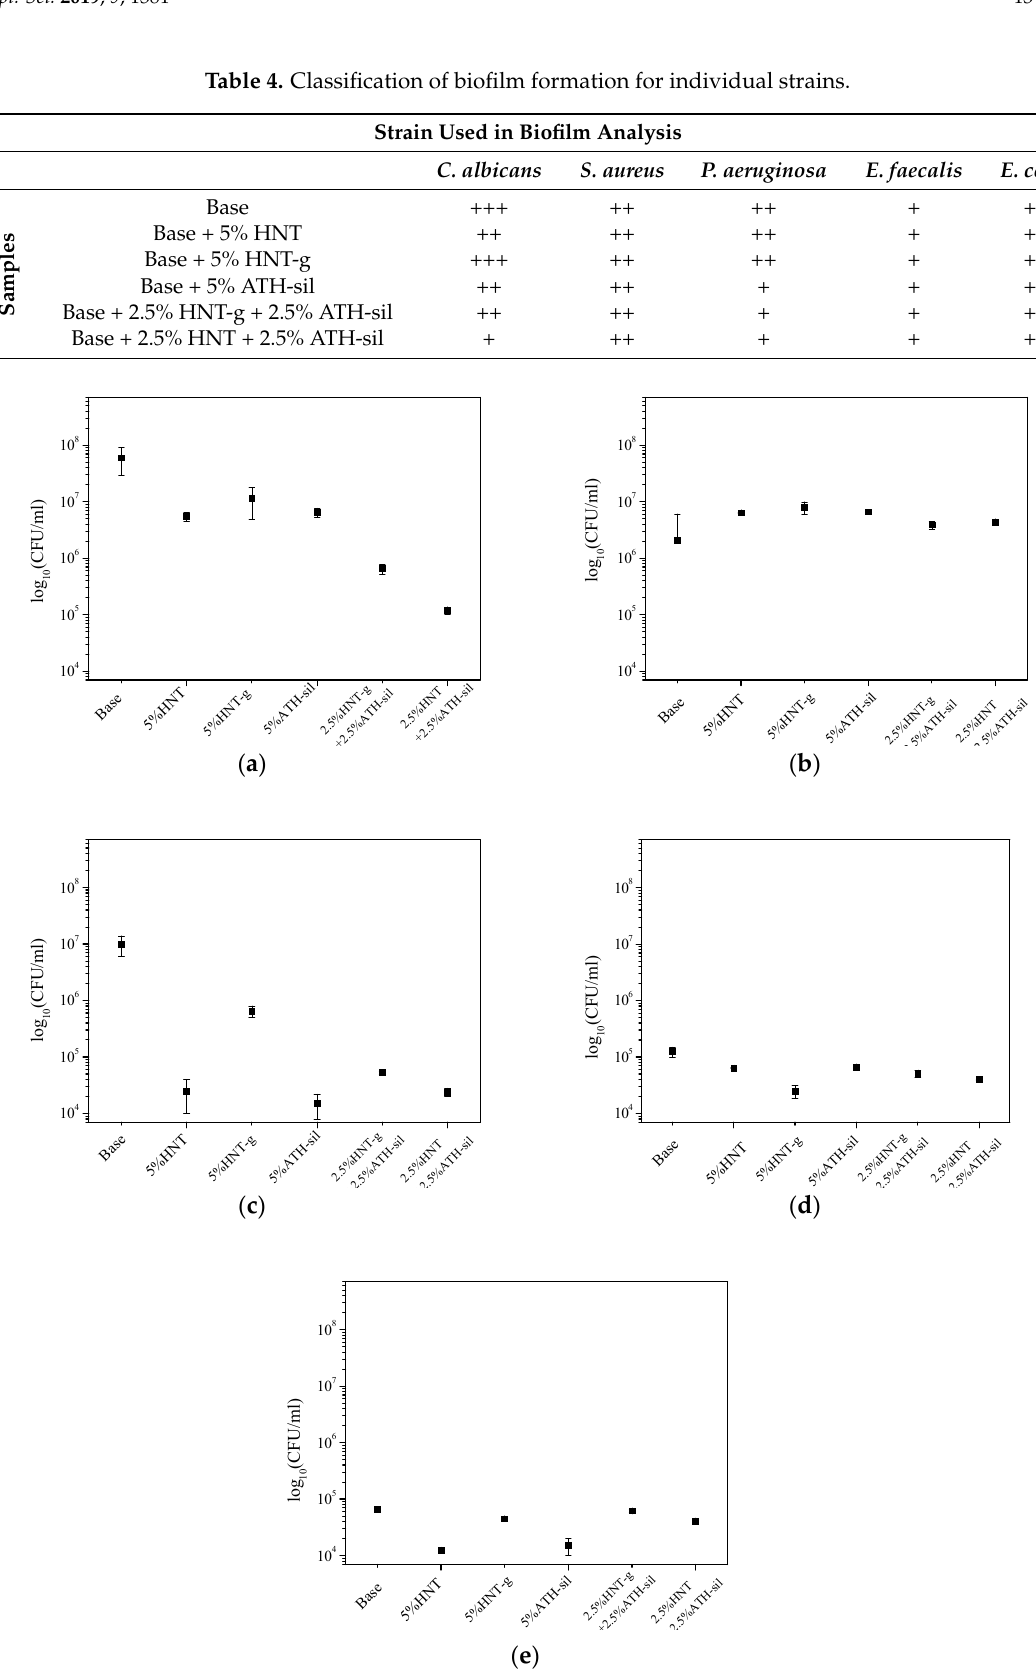
Figure 8. Analysis of the impact of the base material and the prepared composites against the following strains: C. albicans ( a ), S. aureus ( b ), P. aeruginosa ( c ), E. faecalis ( d ), and E. coli ( e )—quantitative method. Table 4. Classification of biofilm formation for individual strains.